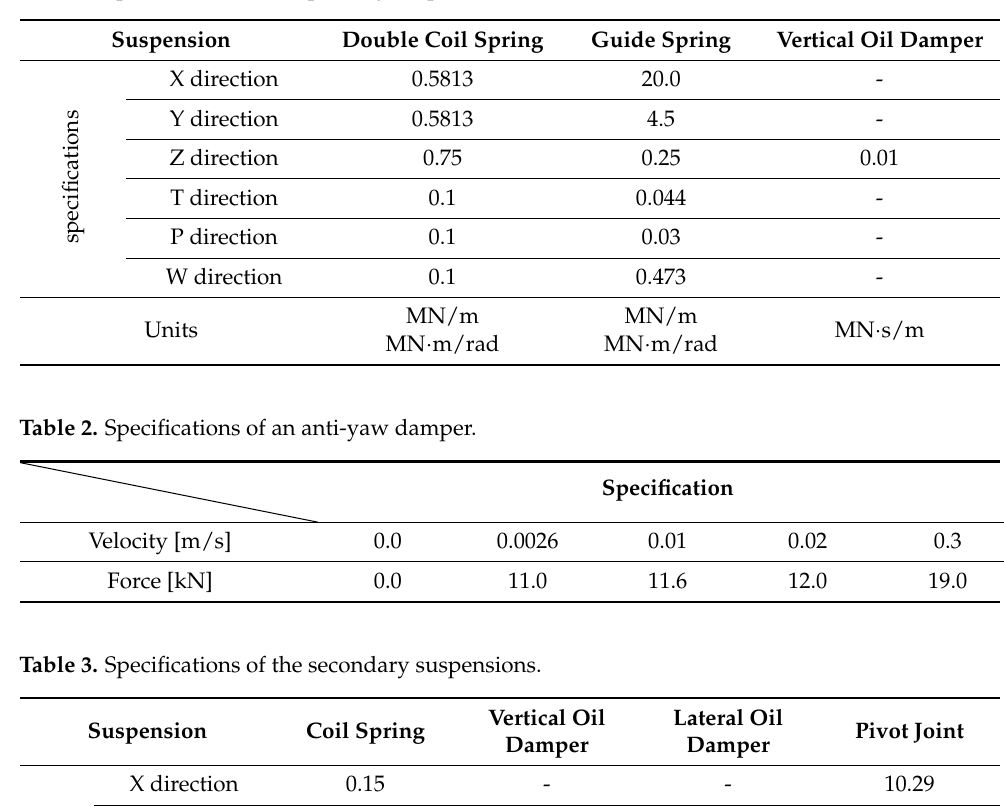
Figure 7. The compositions of suspensions. Table 1. Specifications of the primary suspensions.